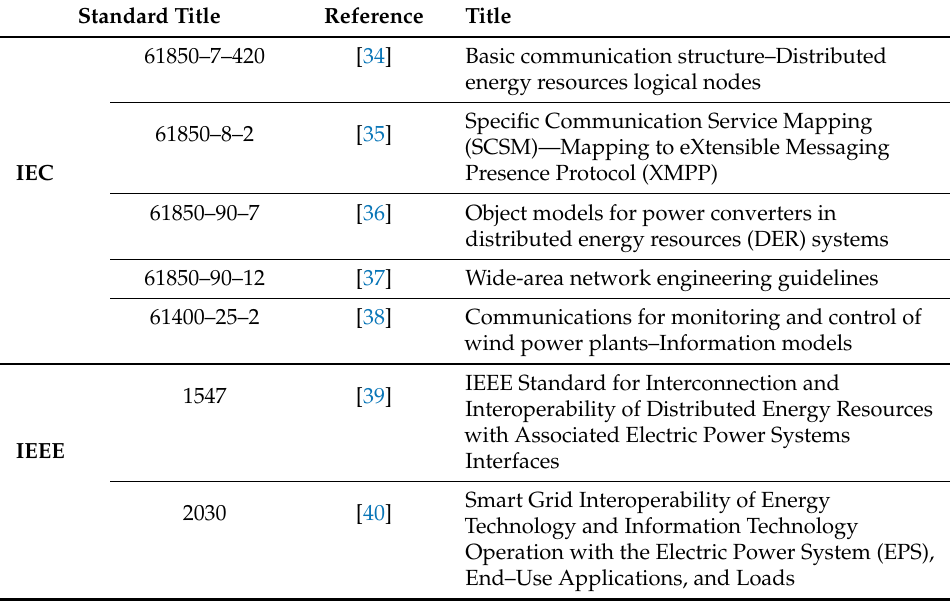
Table 3. MG management- and communication-relevant